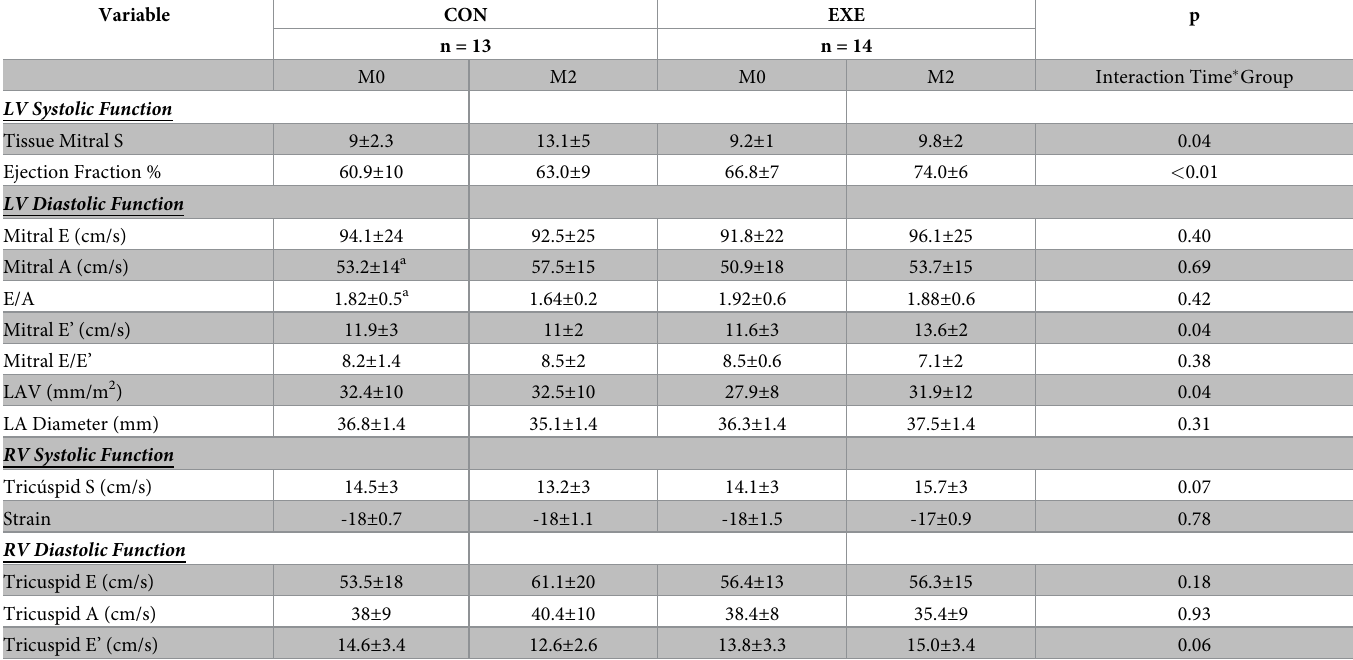
Values presented as mean ± standard deviation. Tissue Mitral S: displacement velocity of the mitral annulus at systole (cm/s); FSVE; Mitral E: filling velocity in the mitral Doppler in the fast filling stage; Mitral A: filling velocity at mitral Doppler at atrial contraction; LAV = left atrium volume calculated by the Simpson method indexed to the body surface; LA: left atrium, RV = right ventricle; Tricuspid S = velocity of tricuspid ring displacement in the period of systole of RV; Tricuspid E and A = tricuspid Doppler filling velocity in the fast filling and atrial contraction phases, respectively; Tricuspid E’ = velocity of tricuspid ring displacement in the fast filling phase. Analysis performed using two-way ANOVA with P <